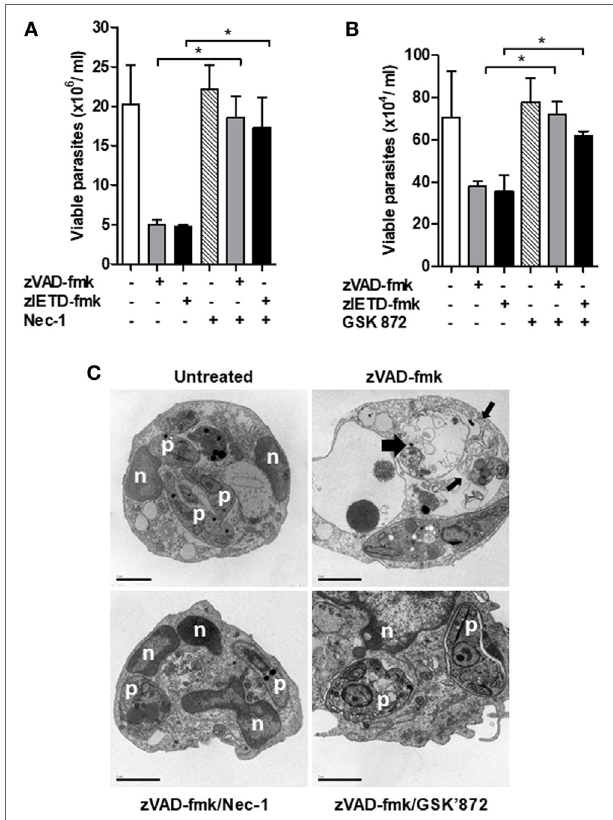
FigUre 5 | Inhibition of RIPK1 and RIPK3 reverses Leishmania infantum killing induced by inhibition of caspase-8. Inflammatory neutrophils from C57BL/6 mice were obtained after i.p. thioglicolate (3%) injection. Neutrophils (5 × 10 5 /well) were pretreated with zVAD-fmk (100 μ M) or zIETD-fmk (100 μ M) for 30 min. After that, cells were infected with L. infantum stationary promastigotes (5 parasites:1 neutrophil) in the presence or not of (a) Nec-1 (50 µM, RIPK1 inhibitor) or (B) GSK’872 (3 µM, RIPK3 inhibitor) followed by cultivation at 26°C and viable promastigotes counts after 1 day. Data shown are from a single experiment representative of three independent experiments. Asterisk indicates significant differences assessed using the Kruskal–Wallis non-parametric test with Dunn’s post-test. * P < 0.05. (c) Representative transmission electron micrographs of inflammatory neutrophils pretreated with zVAD-fmk followed of infection with L. infantum stationary promastigotes in the presence or not of Nec-1 and GSK’872. Morphological features of necroptosis in L. infantum infected-neutrophils pretreated with zVAD-fmk is reversed by inhibition of RIPK1 and RIPK3. Untreated infected neutrophils (negative control), viable parasites (p), intact nuclei (n). Scale bars = 2